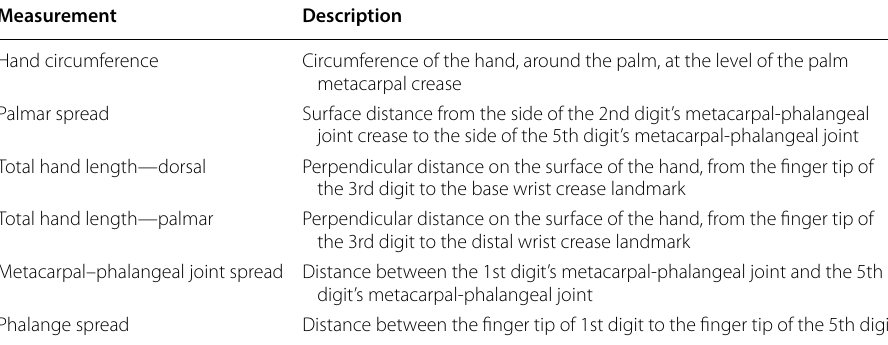
Table 3 Hand measurement examples (Griffin et al.